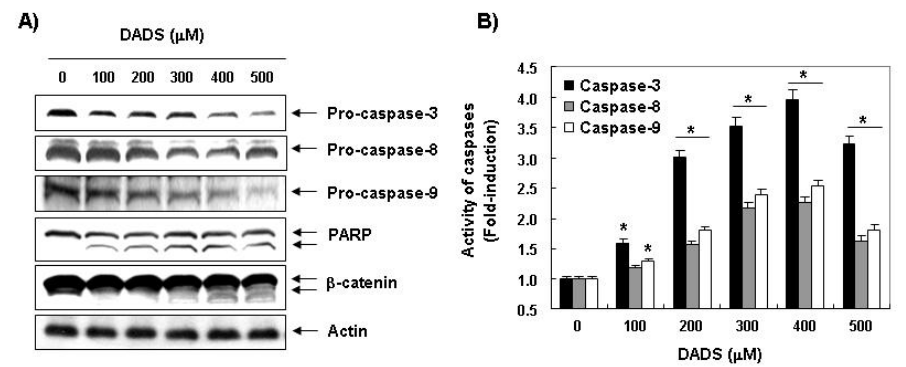
Figure 5. Activation of caspases and the degradation of PARP and β -catenin by DADS in DU145 cells. ( A ) Cells were treated with the indicated concentrations of DADS for 48 h. The cells were lysed, and the cellular proteins were visualized using the indicated antibodies and an ECL detection system. Actin was used as an internal control; ( B ) After 48 h incubation with the indicated concentrations of DADS, the cells were lysed, and aliquots (50 µg protein) were assayed for in vitro caspase-3, -8 and -9 activity using DEVD-pNA, IETD-pNA and LEHD-pNA as substrates, respectively, at 37 °C for 1 h. The released fluorescent products were measured. The data are expressed as the mean ± SD of three independent experiments. The significance was determined by the Student's t -test ( * p < 0.05 vs. untreated control).